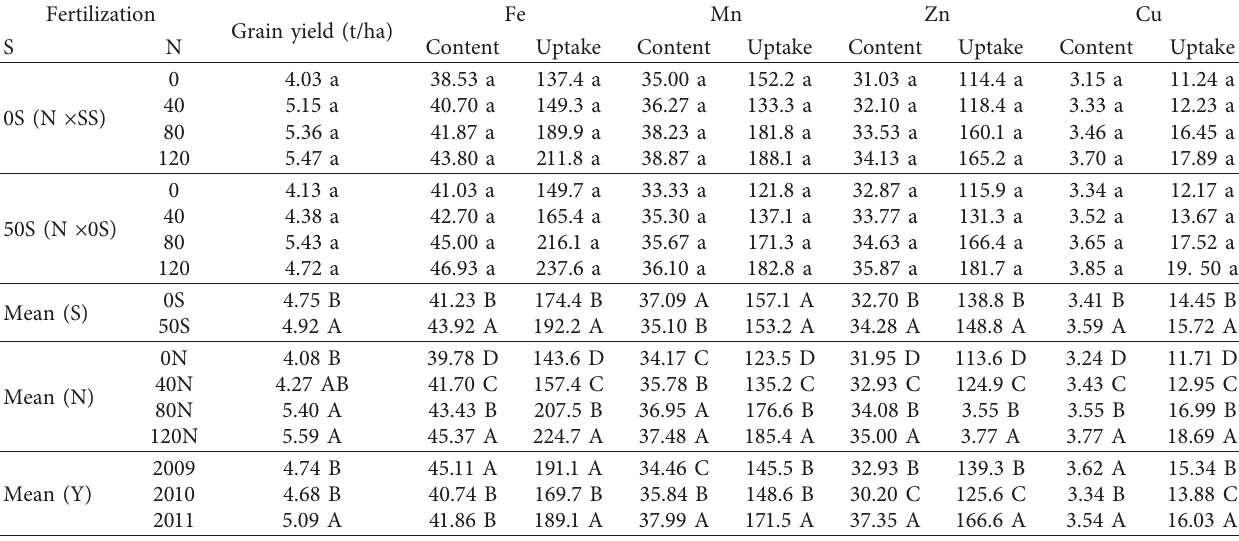
Different letters in the same column indicate significant differences between results at P ≤ 0 .